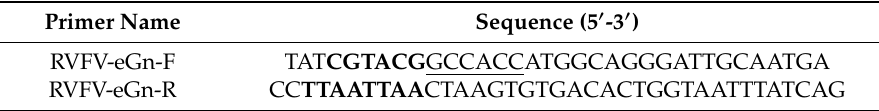
Table 1. Primers used for construction of the cDNA encoding the MP-12 eGn gene of